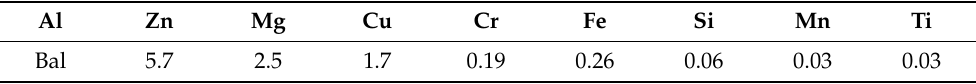
Table 1. Composition of tested AA7075-T651 material heat (in wt. %).